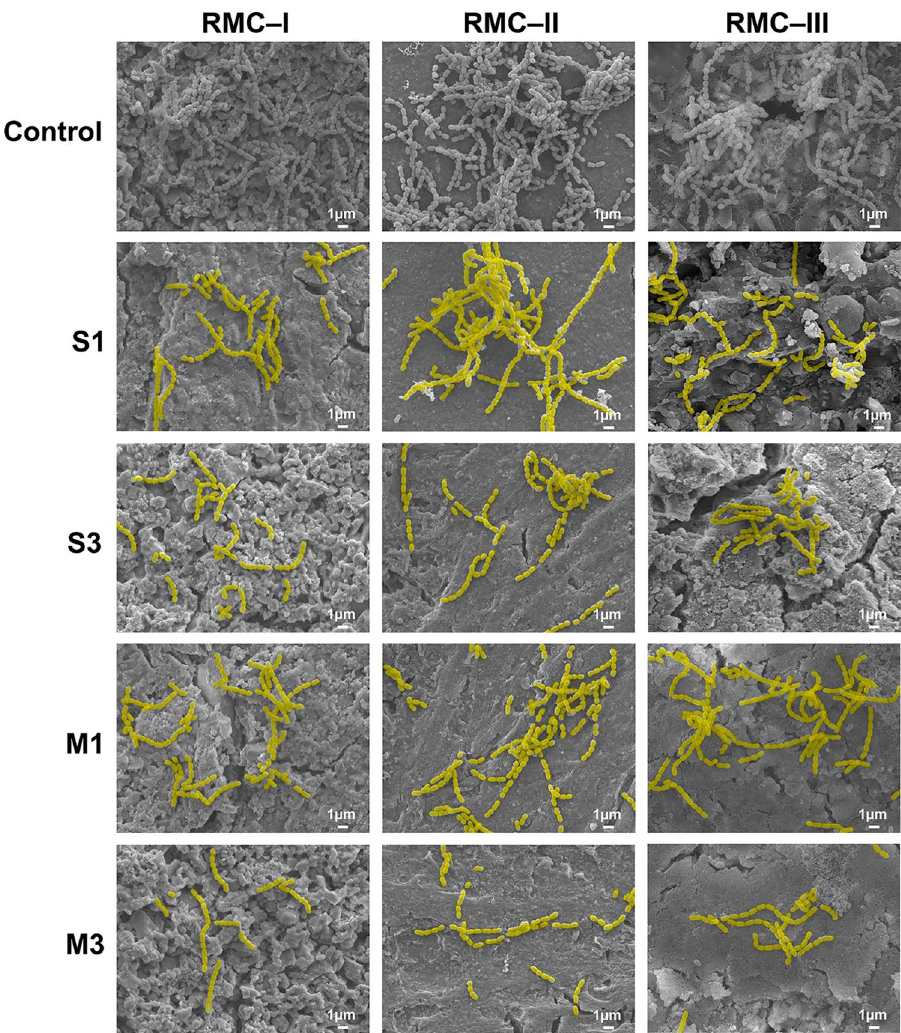
Figure 4. Representative scanning electron microscope images of S. mutans attached to the surfaces of control groups and experimental groups (magnification: 5000 ×). In the experiment groups, S. mutans attachment to the cement surface are pseudo-colored (yellow) for emphasis.